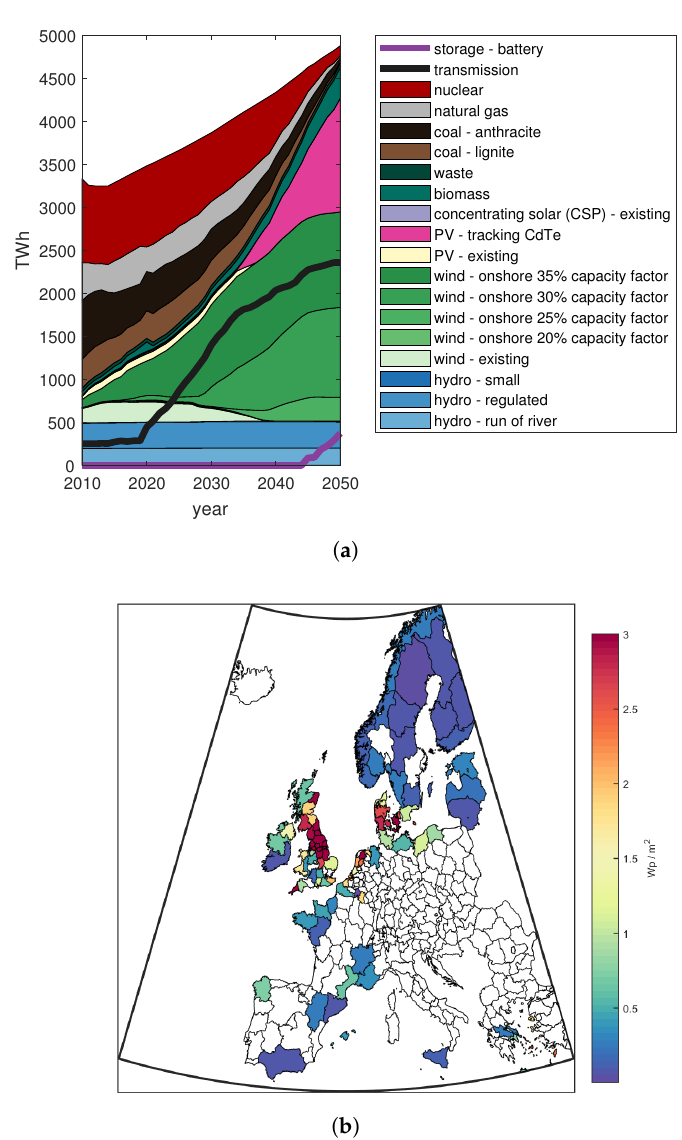
Figure 6. Model results for the lower wind cost scenario including ( a ) the electricity generated by generation type and year plus yearly electricity transmitted internationally and yearly energy transferred to storage, and ( b ) the installed capacity density of wind power. Note that the order of the legends for line and area plots corresponds to the order of the respective values in 2010 from top to bottom. Note also that the color of the regions/quadrants on map plots indicates the installed capacity density in the given region/quadrant where white signifies zero